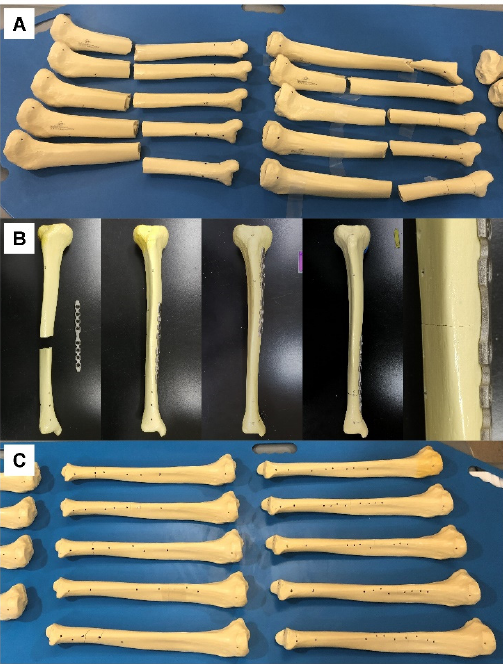
Figure 2. ( A ) Tibial sawbones fractured at various longitudinal locations of the shaft, prior to CT scan. ( B ) Sawbones and customized plates prior to fixation (left image in row), fixed at various locations (middle three images in row), and enlarged at the fracture site (right image in row). ( C ) Tibial sawbones actually fixed with a customized plate based on virtual reduction, prior to CT scan.